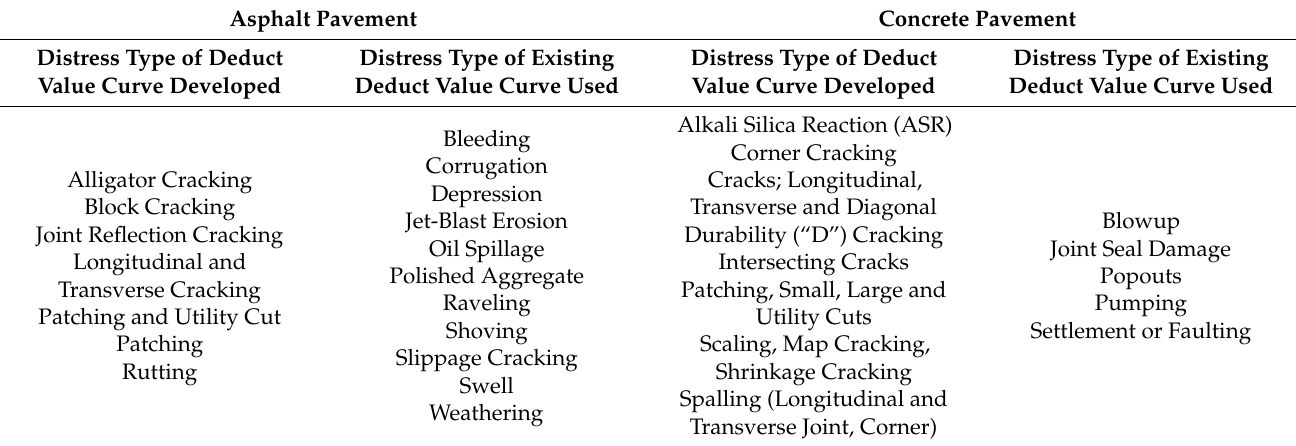
Table 2. Distress Type of Developed Deduct Value